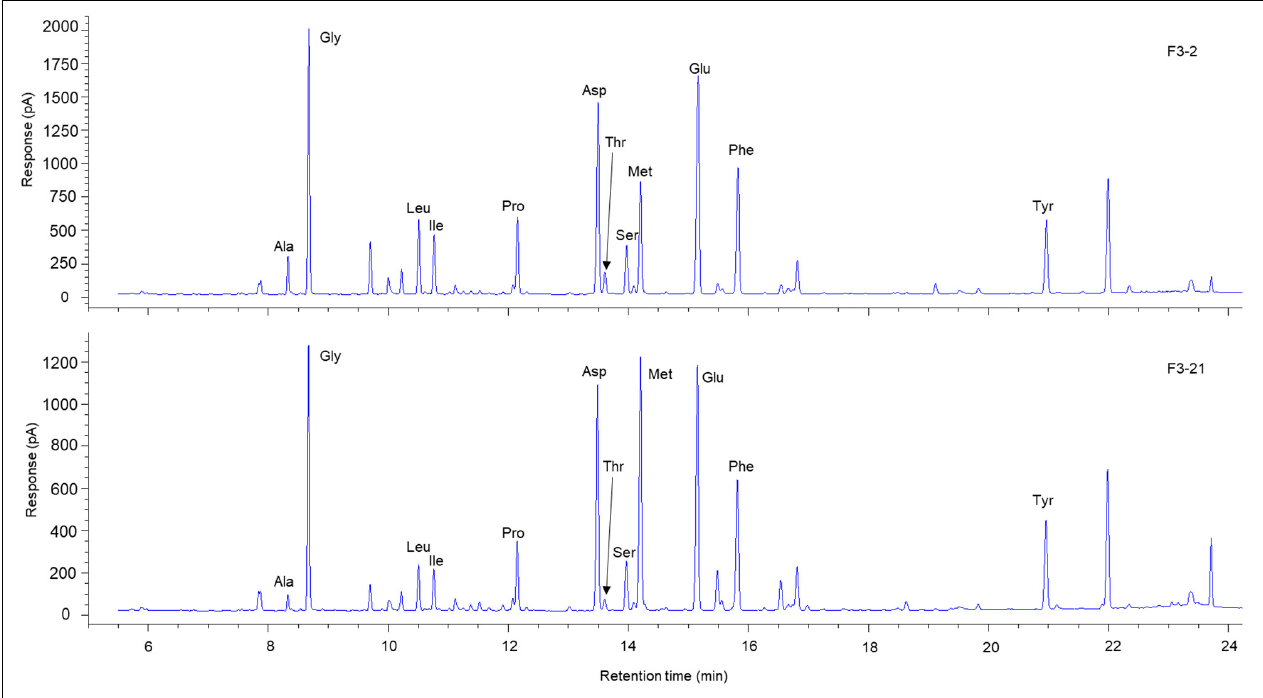
FIGURE 2 | Representative chromatogram of AAs in eye lenses of Chub mackerel. The Met content is substantially higher in the inner laminae, F3-21 ( bottom graph), than in the outer laminae, F3-2 ( top graph).